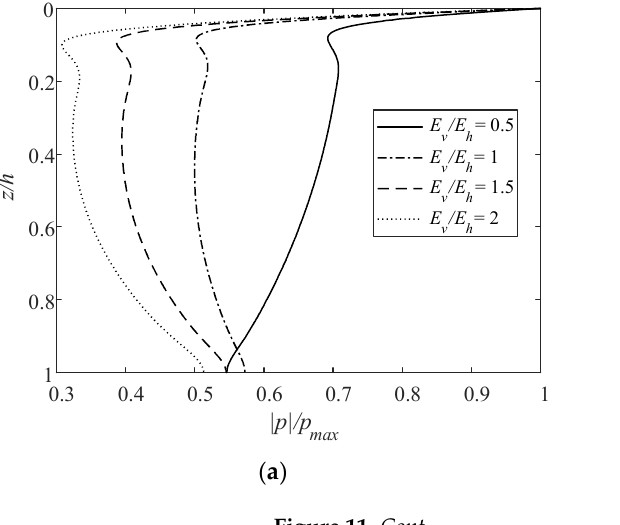
σ | and | zz σ | , and | σ | but also zz xx σ | increases. Meanwhile, the in- zz σ | and | σ | all decay with the increase zz xx